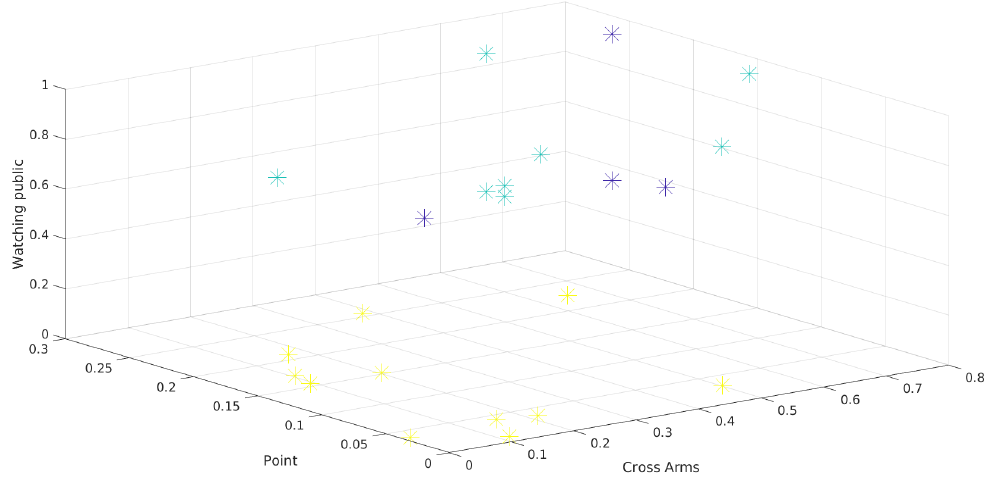
Figure 9. 3D Scatter plot of presentation 3 in year 1.